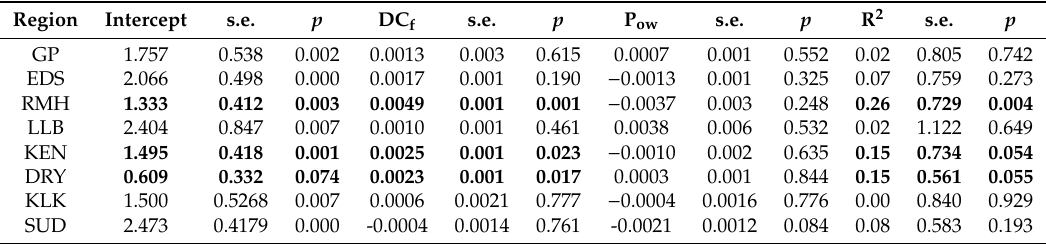
Table 4. Linear regression model coe ffi cients along with corresponding standard errors (s.e.) and p-values (p) for the logarithm of area burned in the spring. Explanatory variables tested include the DC value at the end of the previous season fall (DC f ) and overwinter precipitation (P ow ). Coe ffi cients and final models with very high to moderate confidence (p < 0.1) appear in bold.